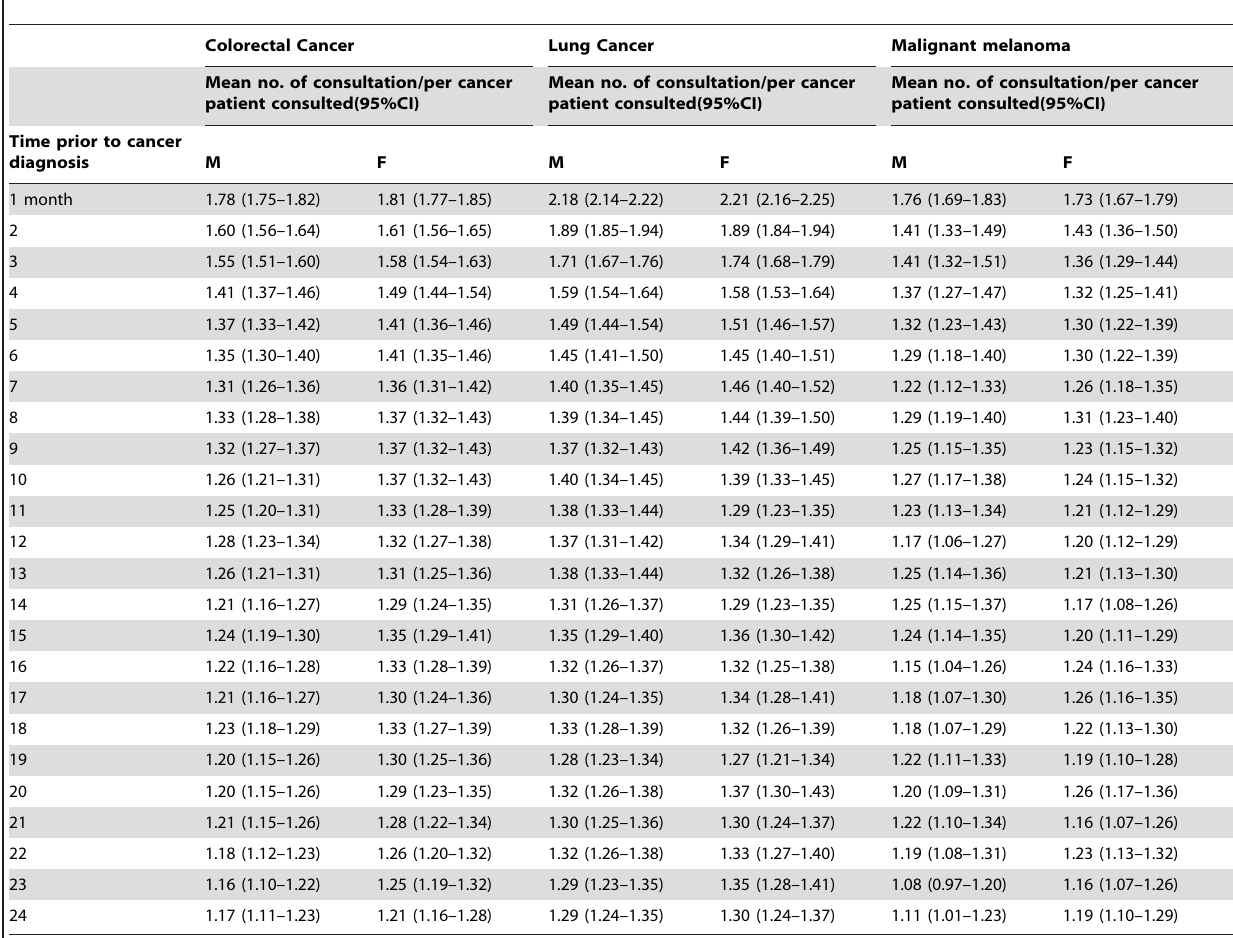
Table 5. Mean number of primary care consultations per cancer patient (aged 16 + ) had in each month preceding their recorded cancer diagnosis by